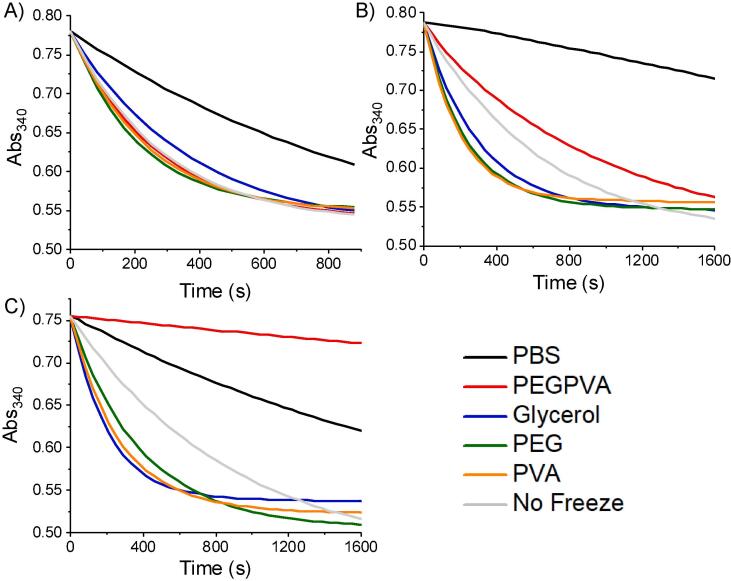
Variable storage period analysis. All samples were plunge frozen into Liq. N2, stored at −20 °C for indicated period of time and then thawed at 37 °C. A) 24 h; B) 7 days; C) 1 month. PEG = 100 mg.mL−1, PVA = 1 mg.mL−1.